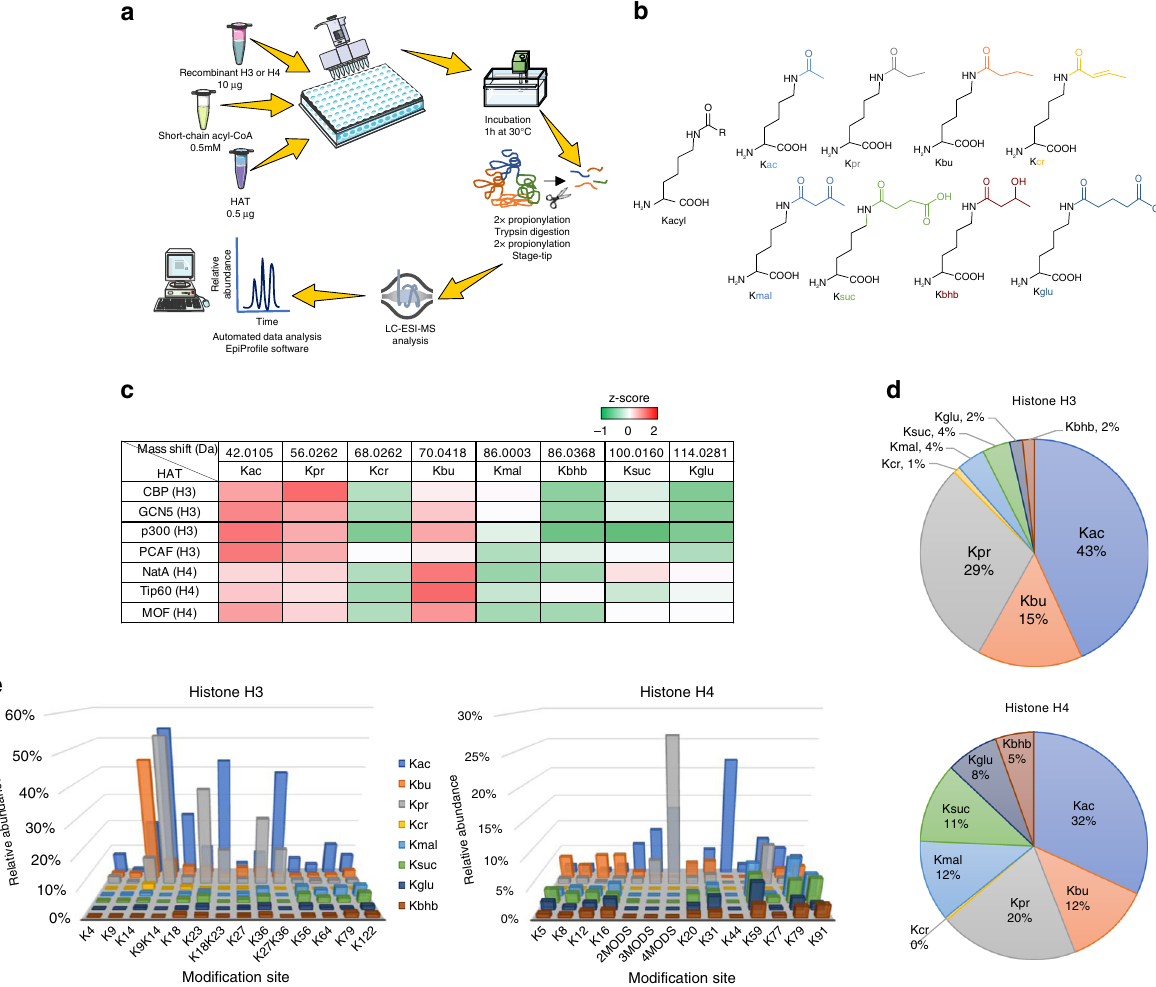
Fig. 1 Overview of histone acetyltransferases (HATs) in vitro acylation activity and speci fi city. a Schematic representation of in vitro acylation assay. b Chemical structures of histone acyl modi fi cations evaluated in this study. Lysine modi fi cations and abbreviations are: acetyl (Kac), propionyl (Kpr), butyryl (Kbu), crotonyl (Kcr), malonyl (Kmal), succinyl (Ksuc), β -hydroxybutyryl (Kbhb), and glutaryl (Kglu). c Heat map displaying the in vitro acylation activity pro fi les of different HATs in the presence of acetyl-, propionyl-, crotonyl-, butyryl-, malonyl-, β -hydroxybutyryl-, succinyl- and glutaryl-CoA. Molecular mass shift of the various acylated lysines residues are shown in the table headers. Different HATs were assayed against histones H3 or H4 as speci fi ed in the fi rst column. To generate the heat map, we averaged the relative abundance of acyl-PTMs on the quanti fi ed peptides and then normalized (z-scores) those values across the different HATs, i.e. row normalization. d Pie chart showing the average relative frequency of in vitro acylated peptides, divided in results for histone H3 (top) and histone H4 (bottom). e Bar plots depict the speci fi city for all HATs on the histone sequence. The x axis represents the modi fi cation site at histones H3 (left) and histone H4 (right), and the y axis represents the relative abundance shown as the average contribution of HATs to all acylated peptides. For histone H4 N-terminal peptide (G4-R17), the number of acylations on the sequence are displayed using the code 2, 3 or 4 mods. This is because it was not always possible to discriminate modi fi cation sites on the multiply modi fi ed H4 peptide. All values shown were corrected by the contribution of non-enzymatic acylation. All results are shown as the average of 3 independent